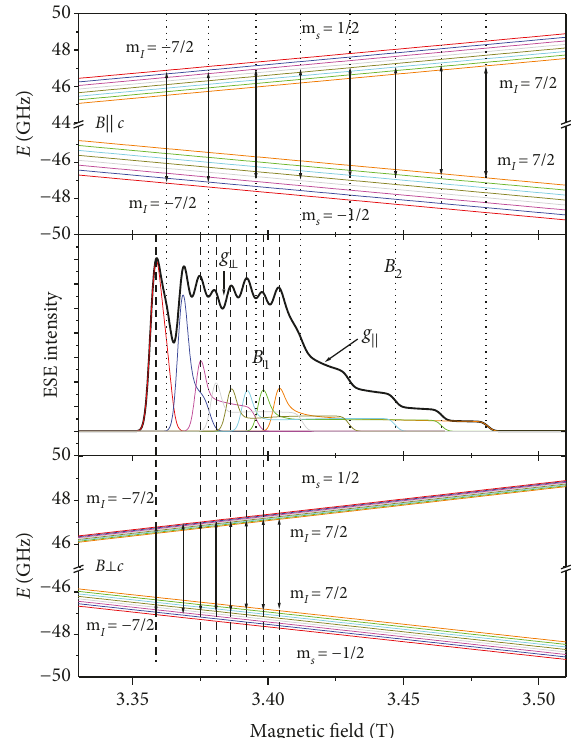
Figure 5: The energy levels (the top panel for the magnetic fi eld directed along “ out-of-plane ” while the bottom one for the magnetic fi eld “ in-plane, ” see Figure 3) and the corresponding absorption EPR spectrum (central panel) for VO 2+ complex calculated for the microwave frequency ν = 94GHz , g ∥ = 1 96 , g ⊥ = 1 98 , A ∥ = 470 MHz , and A ⊥ = 150MHz . Particular contributions from every EPR transition are color-marked. Calculations are done in EasySpin package for MatLab [59] in the assumption that the main axes of g and A tensors coincide. The arrows mark the values of the magnetic fi eld equivalent to the values of g ∥ and g ⊥ . The values of external magnetic fi eld that correspond to the EPR transitions with m I = +3/2 are denoted as B and B . 1 2